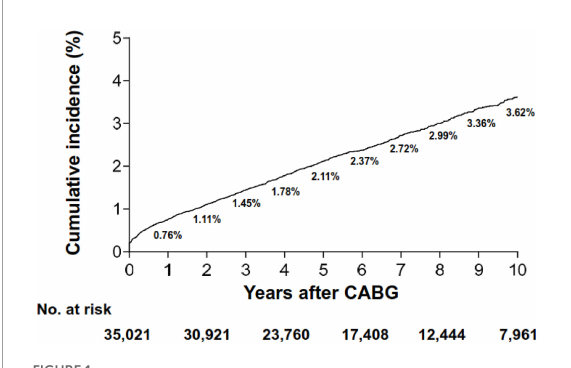
FIGURE1 Cumulative incidence of intracranial bleeding. CABG, coronary artery bypass grafting